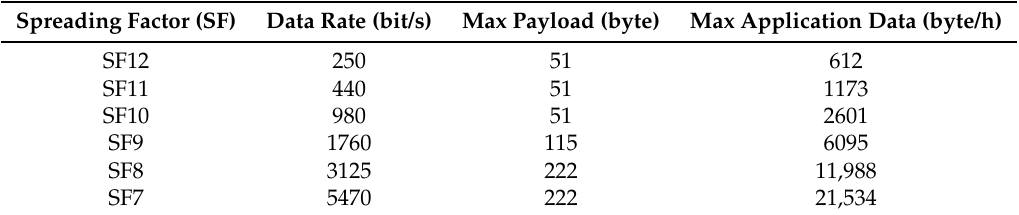
Table 4. LoRaWAN bandwidth per sub–band for Spreading Factors (SF) 7 to 12, calculated at 1% duty cycle, with code rate 4/5 and a 125kHz bandwidth. Longer distances are achieved with a higher SF which reduces the maximum data transfer. Data Rate and Max Payload from [48]. Other restrictions on usage may lower the available data transfer.